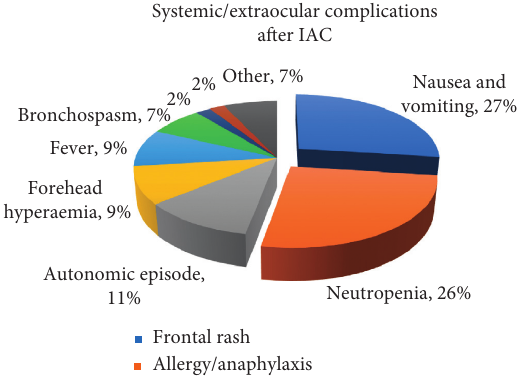
Figure 7: Systemic and extraocular complications following